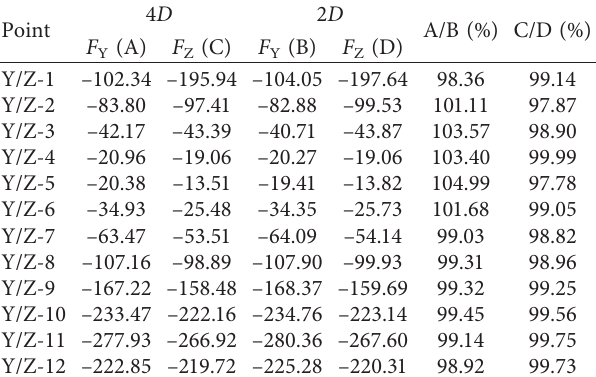
displacement of a secondary-lining monitoring point of the left tunnel after the excavation of both tunnels is completed. Table 7: Axial force on both tunnels (kN).